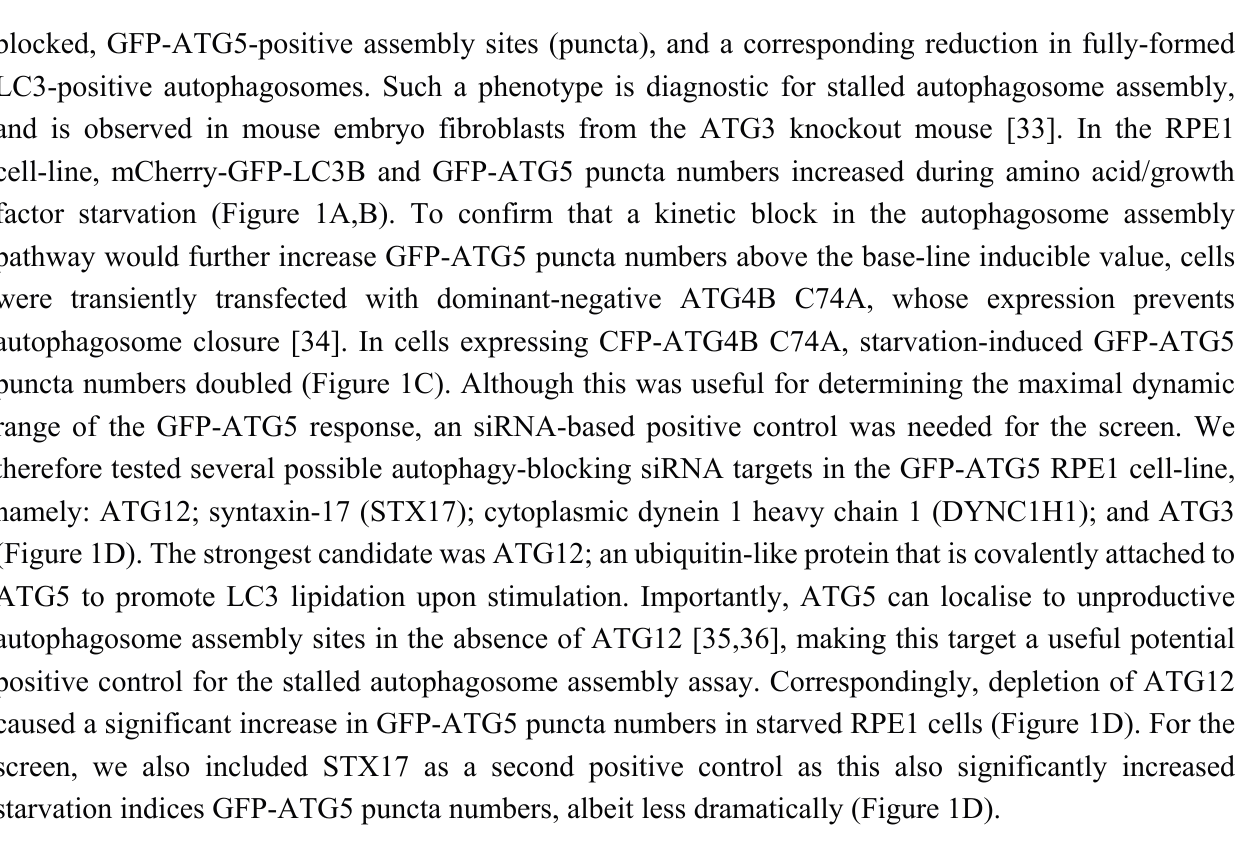
Table 1. Summary of the autophagy and mitophagy